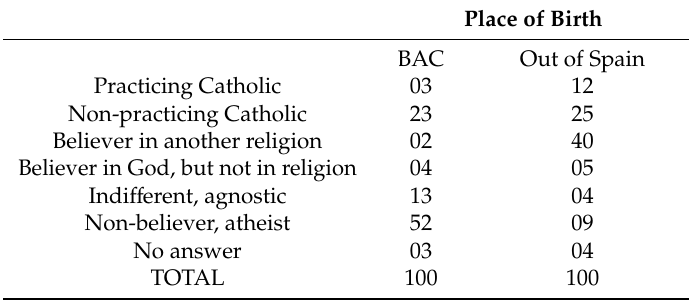
Table 4. Religious self-adscription of youngsters according to the place of birth